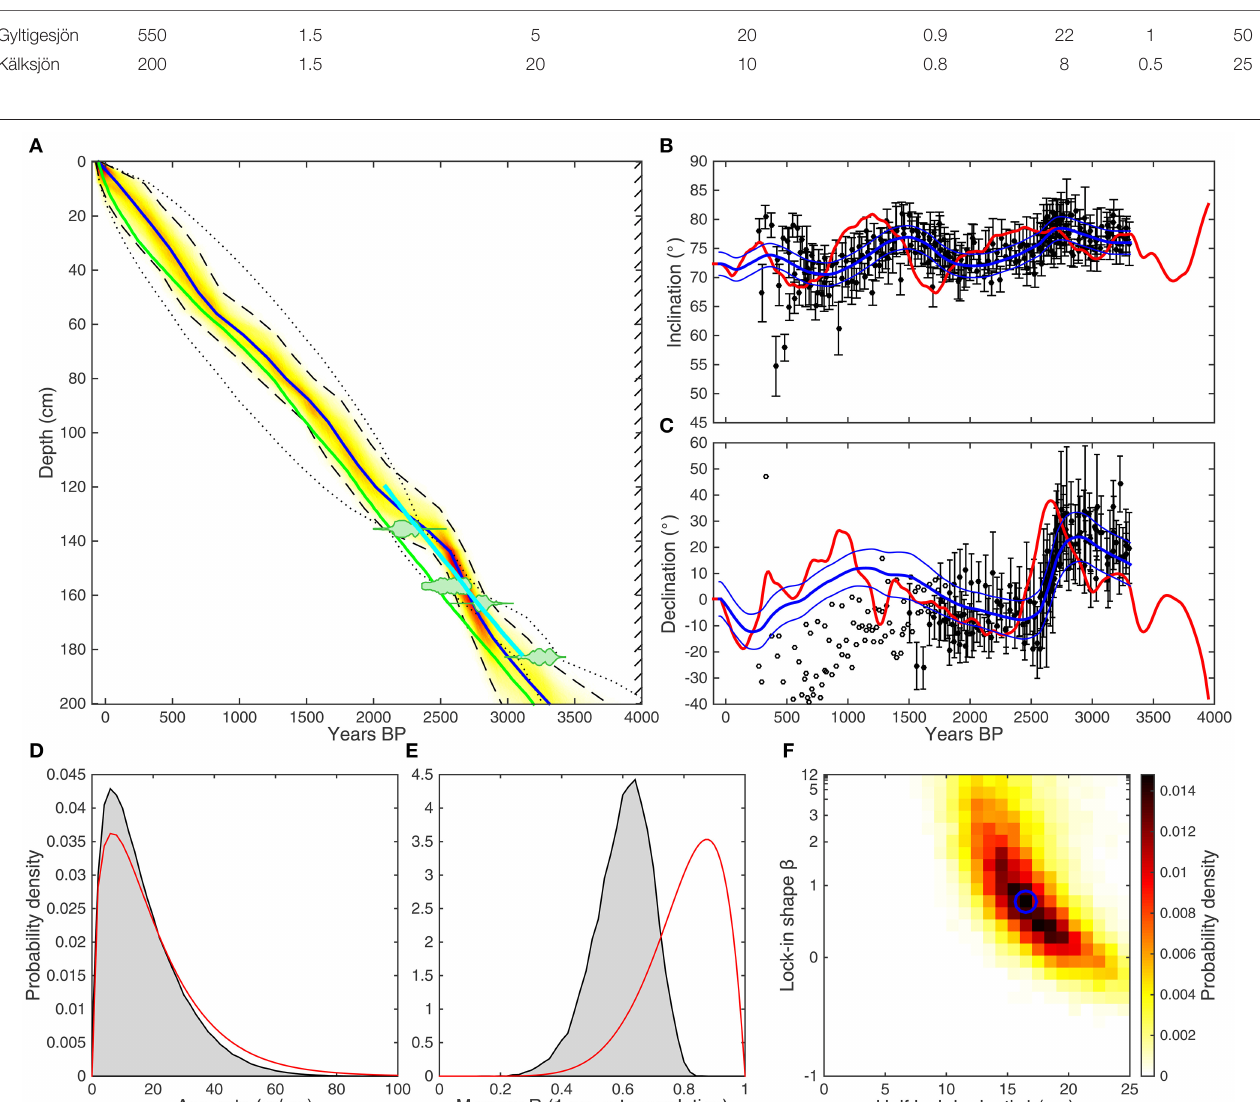
FIGURE 4 | (A) The age-depth posterior distribution for Kälksjön based on paleomagnetic data (yellow/red shading) with the 95% confidence envelope (dashed black) compared to the wiggle-match chronology (solid cyan), the adjusted varve chronology (solid green) and the 95% confidence envelope of the radiocarbon-based chronology (dotted black). Calibrated probability density curves of available macrofossil radiocarbon dates are shown for reference as green shaded areas. The blue line represents the preferred age-depth model based on the weighted mean age for each depth. (B) Inclination and (C) declination data (filled black circles) with 1 σ error compared to the ARCHk_cst.1 geomagnetic field model prediction (solid red) filtered with the preferred lock-in function (solid blue) with one sigma uncertainty envelope. Rejected data are shown as open black symbols. In the lower panels: The prior (red) and posterior (gray) distributions of (D) accumulation rate and (E) memory. (F) The posterior distribution of the half lock-in depth ( l ) and lock-in shape ( β ), where the blue circle marks the “preferred” parameters, determined by the grid cell with highest